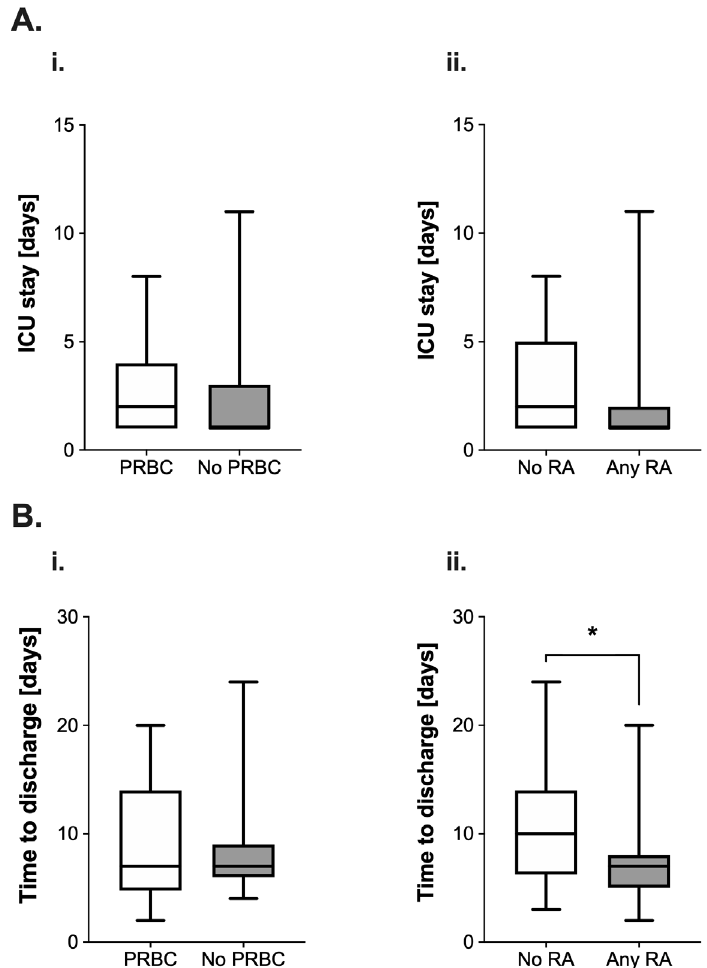
Figure 3. ( A ) Analysis of postoperative length of stay (in days) on the intensive care unit (ICU) in pediatric patients undergoing surgery for nephroblastoma. Data are presented as boxplots (median with quartiles, whiskers representing minimum and maximum). Patients were categorized into groups in accordance with their respective intraoperative treatment: ( i ) intraoperative administration of packed red blood cells (PRBC, white boxplot) vs. no administration of PRBC (grey boxplot) and ( ii ) no regional anesthesia as part of the anesthetic regimen (white boxplot) vs. perioperative use of regional anesthesia (RA, grey boxplot). ( B ) Analysis of the time to discharge (in days) after tumor surgery for nephroblastoma in pediatric patients. Patients were categorized into groups in accordance with their respective intraoperative treatment: ( i ) intraoperative administration of packed red blood cells (PRBC, white boxplot) vs. no administration of PRBC (grey boxplot) and ( ii ) no regional anesthesia as part of the anesthetic regimen (white boxplot) vs. perioperative use of regional anesthesia (RA, grey boxplot). * p < 0.05 for comparison as indicated.